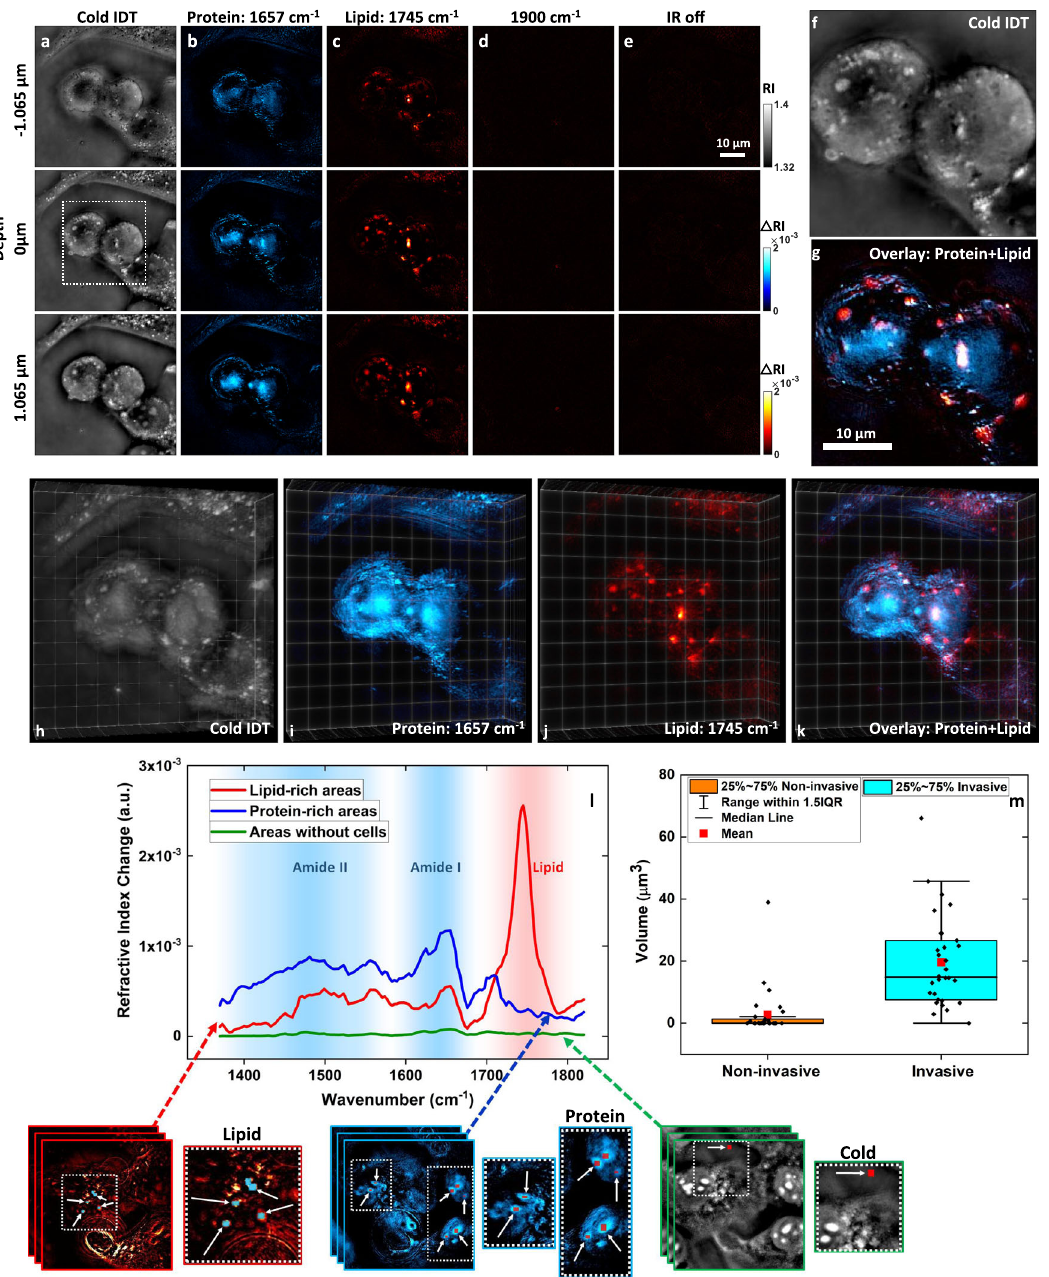
Fig.3|BS-IDTimagingonbladdercancercells.a – k 3Dchemicalimagingof fi